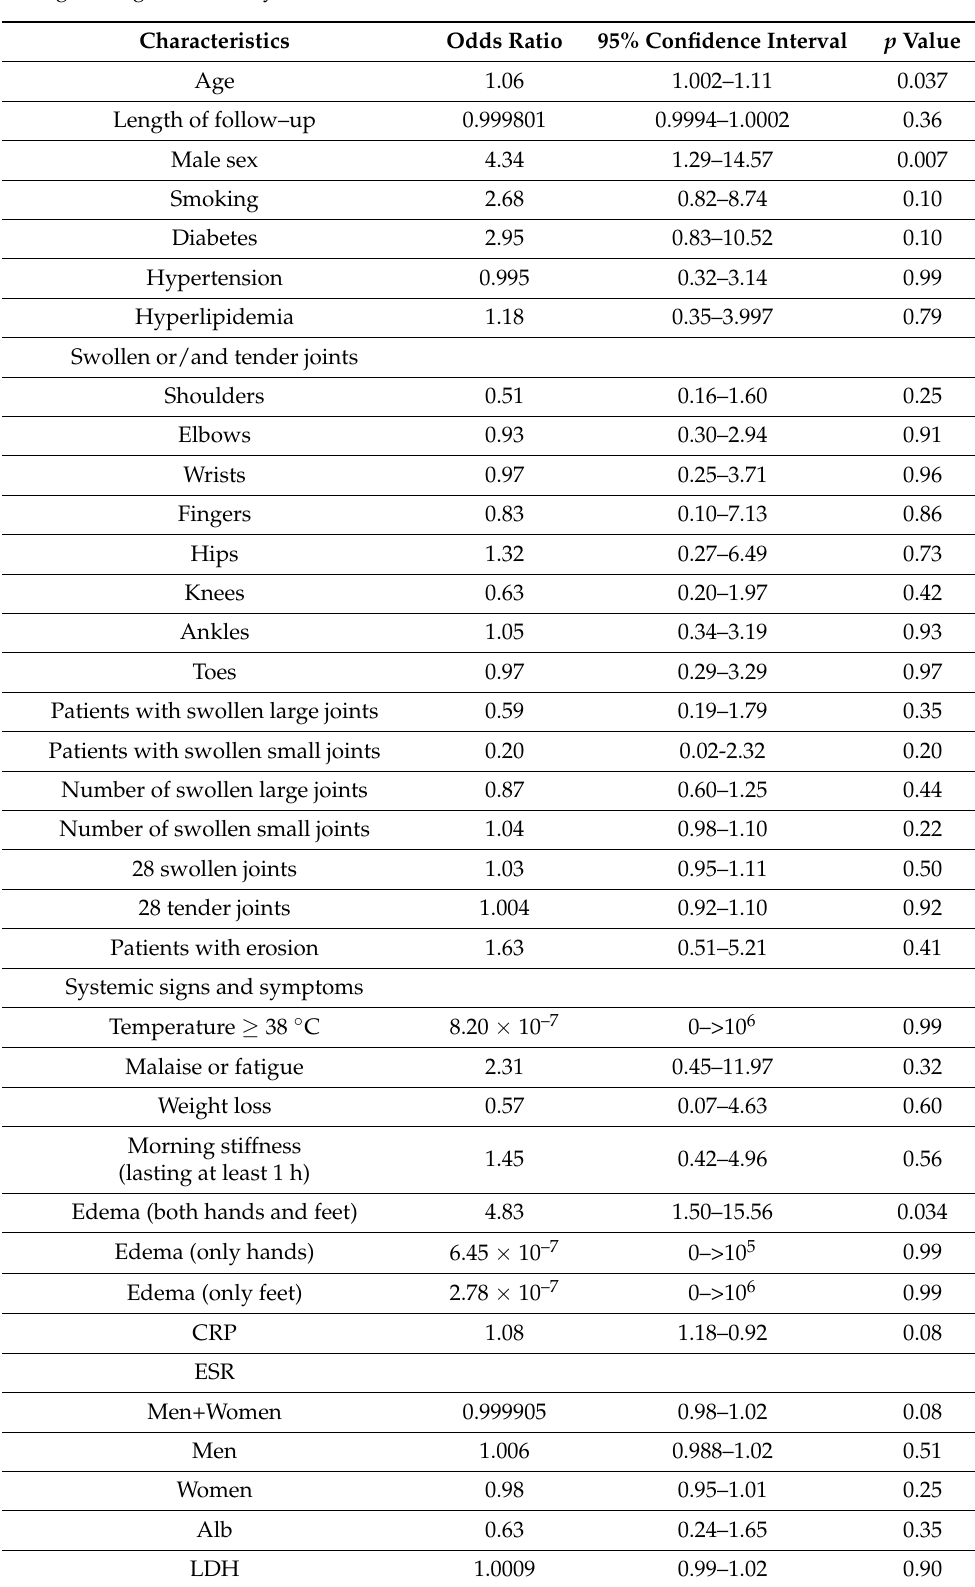
Table 5. Risk factors for malignancy in patients with RS3PE or seronegative RA analyzed by univari- ate logistic regression